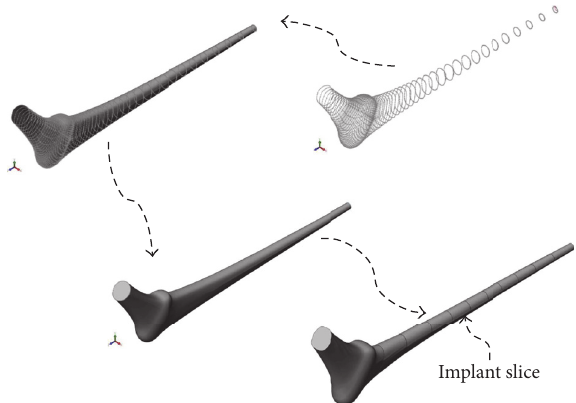
Figure 4: A fixed number of points were imported to the graphical interface of SolidWorks and interpolated with splines (top right), a closed surface envelope was mapped over the splines including the caps on both ends (top left), the enclosure was then filled, and a solid model of the implant was formed. The lengthwise slicing on the bottom right is optional.